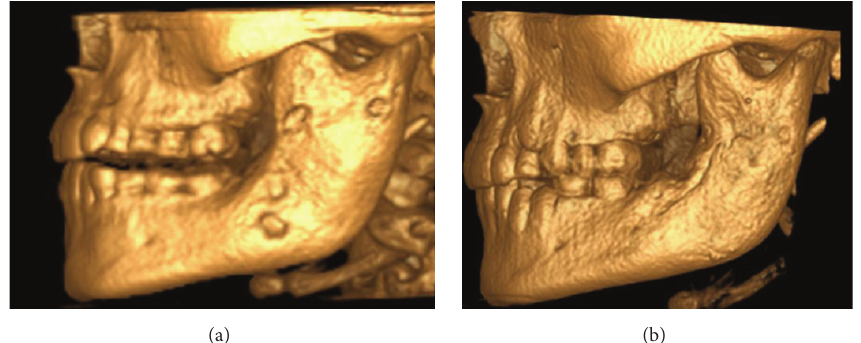
Figure 4: Case 1. CBCT 3D images: (a) preoperative image and (b) six-month postoperative